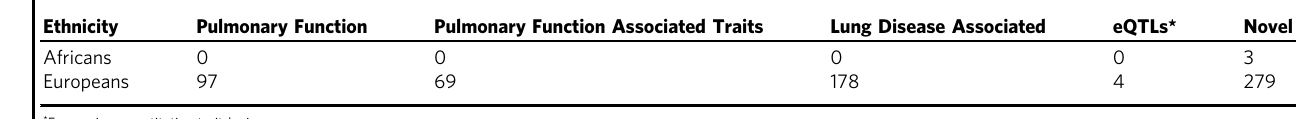
Table 1 Known and novel variants associated with pulmonary